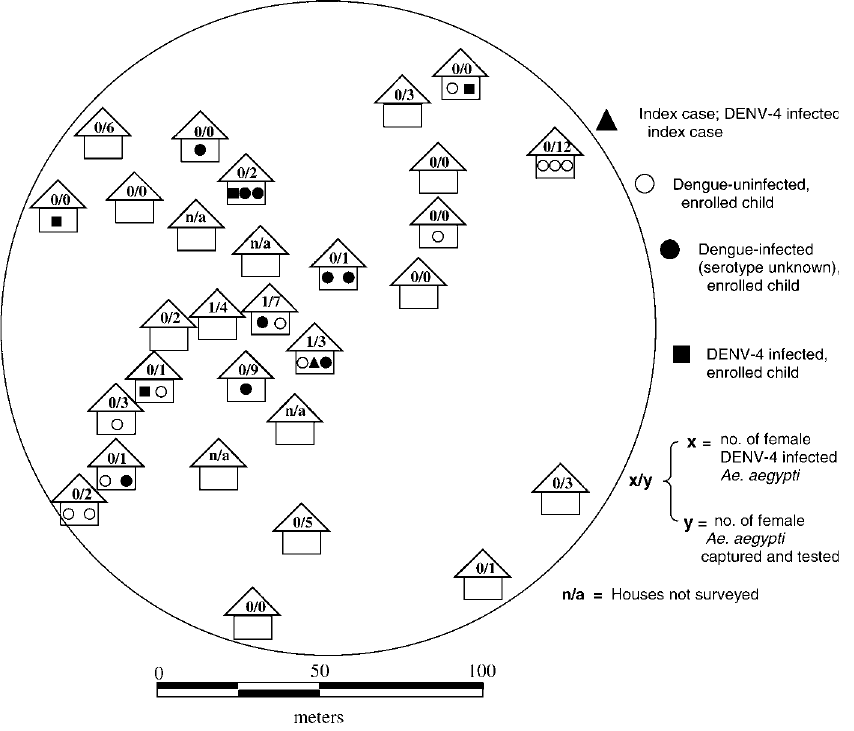
Figure 2. Intense DENV Transmission in Cluster 4 Cluster number 4 illustrates extensive DENV transmission occurring within a 15-d period. In comparison, the paired negative cluster (cluster number 5, not shown) included 22 houses, 21 Ae. aegypti , and 15 contacts with no evidence of DENV transmission within a 15-d period. These index cases were 258 m apart and the cluster investigations were initiated 2 d apart.